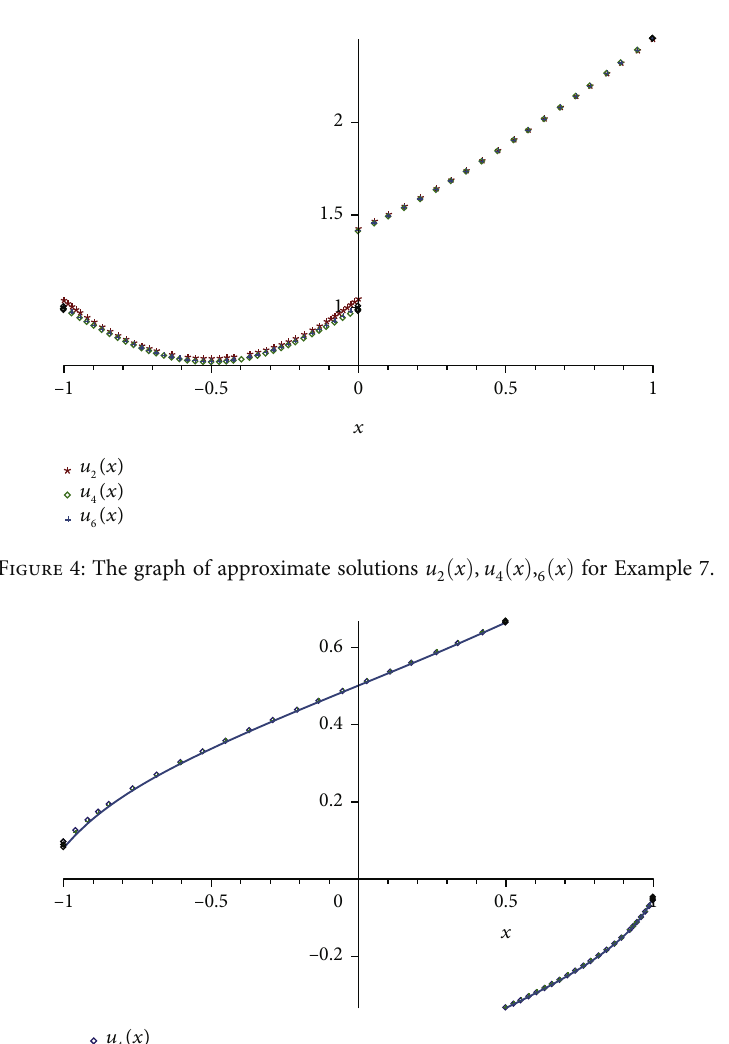
ð x Þ , u ð x Þ , u ð x Þ for Example 4 6 8